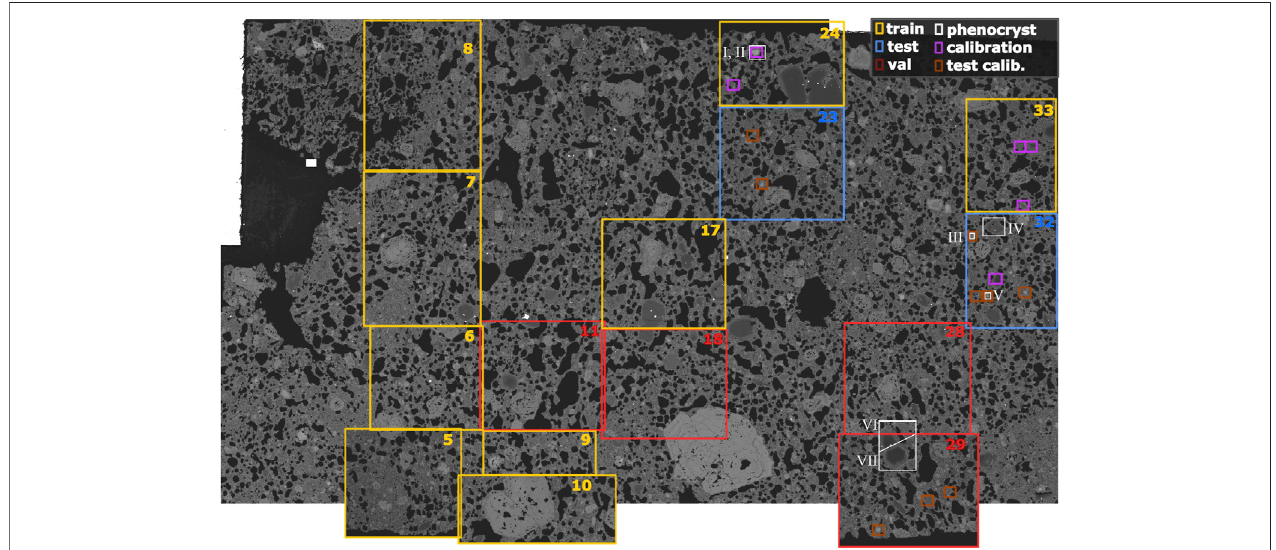
FIGURE 1 | BSE map of the entire thin section with selected areas used for training (large yellow frames), testing (blue frames) and validation (red frames). Small purple frames contain areas with olivines used for calibrations of the BSE grey scale against EPMA mg# . These purple frames and small white fi lled rectangular on a left upperpartoftheFigureshowthesizeofsingleEDS-BSEtiles.Numbersshowanalyticalsessions.Olivinespresented inthispaperarewhitecolorcontoured andlabeled as I, II etc.